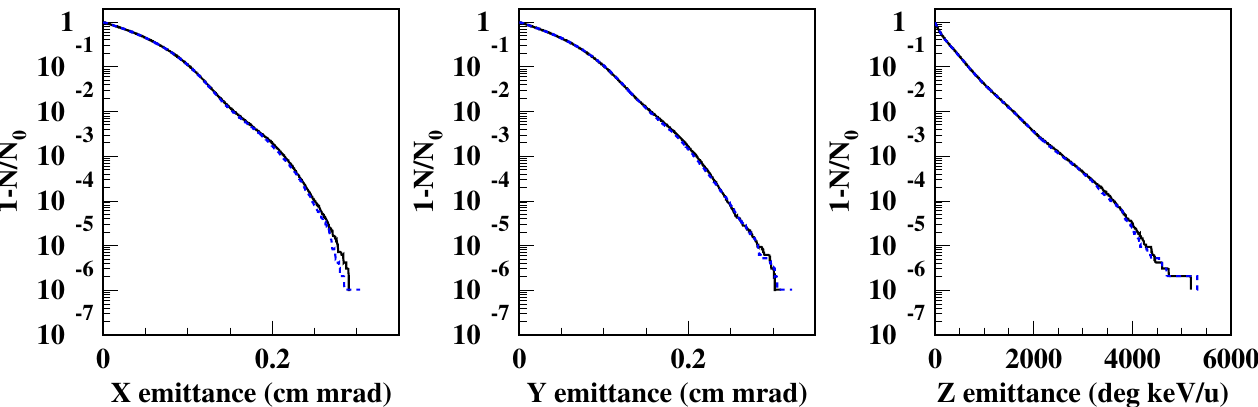
FIG. 11. (Color) Emittance levels, or fractions of the beam outside a given emittance, in the three phase space planes. The solid-black curves are from the serial version and the dashed-blue are from the parallel version.